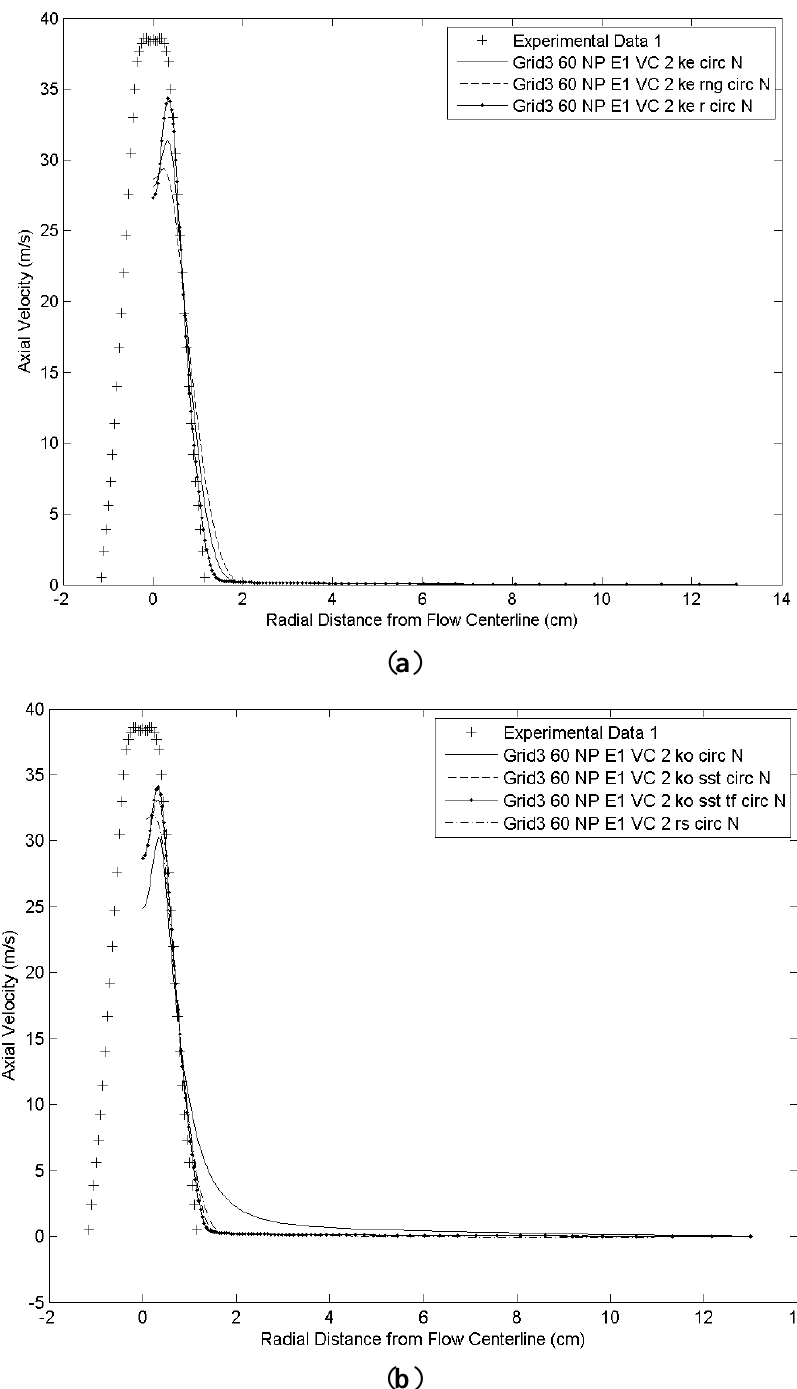
Figure 16. Comparison with experiment of results from ( a ) standard k -  (ke), k -  realizable (ke r) and RNG k -  (ke rng) models at z = 5 cm from the nozzle; ( b ) standard k -ω (ko), k -ω sst (ko sst), k -ω sst tf (ko sst tf) and the Reynolds Stress (rs) models at z = 5 cm from the